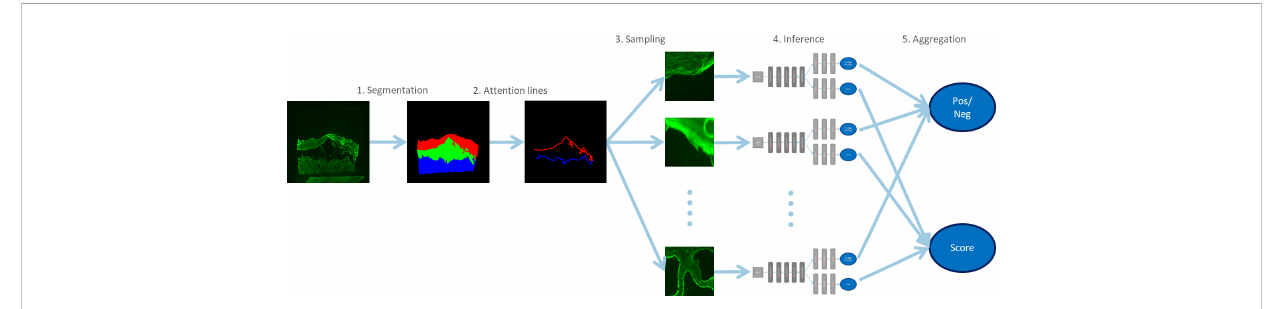
FIGURE 2 Overview of the steps for processing salt-split skin images. Segmentation is used to identify relevant parts of the image. Samples of these subregions are then analyzed via deep networks and the results are aggregated. This approach ensures low memory requirements and good